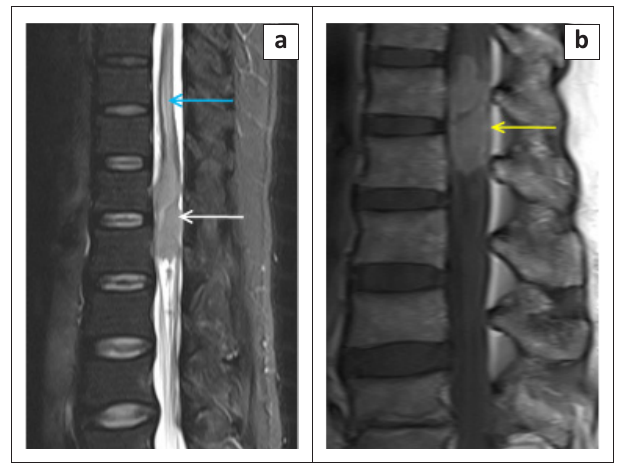
FIGURE 6: Intramedullary haemangioblastoma in a 24-year-old woman. The sagittal T2-weighted image (a) demonstrates heterogeneous cord expansion (white arrows), syrinx formation (yellow arrows) and prominent flow voids (blue arrows). The contrast-enhanced sagittal T1-weighted image (b) demonstrates a well-circumscribed, intensely enhancing mass (red arrow), syrinx formation and prominent flow voids (blue arrow).